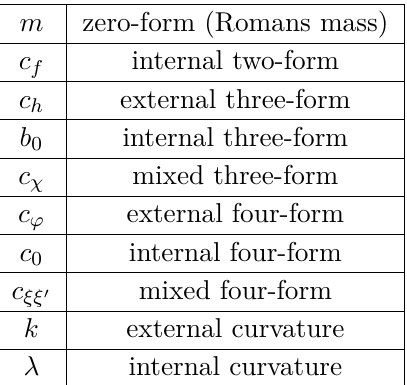
Table 2 . List of the constant coefficients entering the potential (3.4) of the 1d consistent truncation, and their 10d origin. A form is called external (resp. internal), if all its legs are along the external (resp. internal) directions; mixed if one of its legs is along the time direction, while all remaining legs are